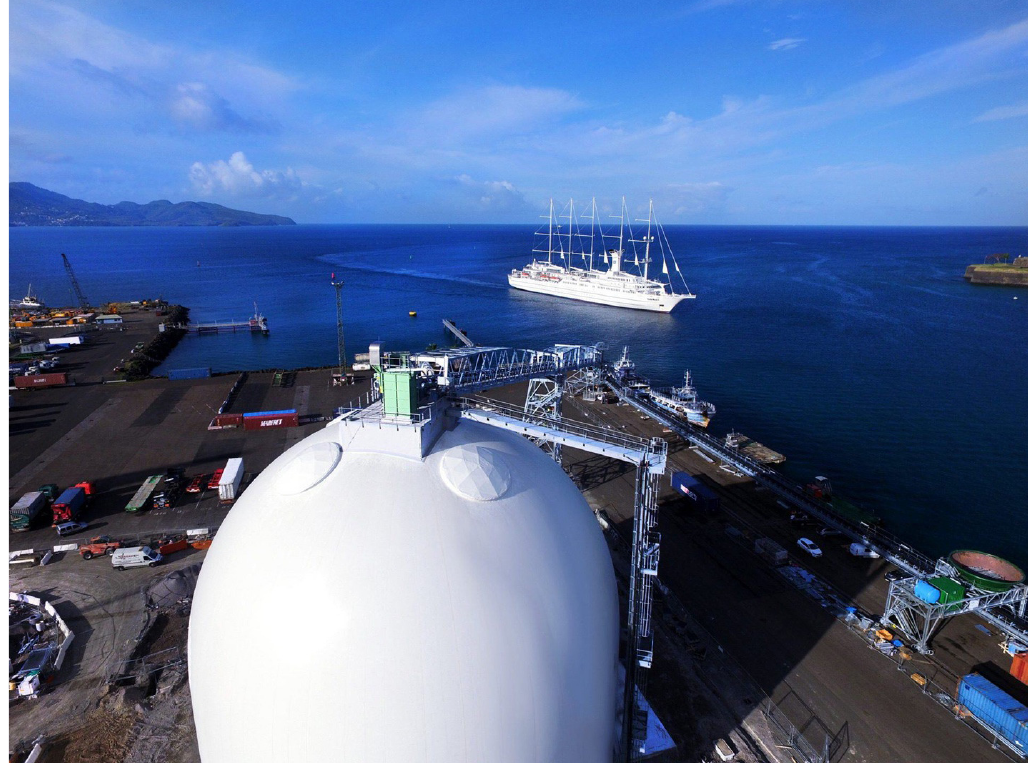
Figure 5. Albioma Wood Pellet Dome in Martinique. Source: Dome Technology